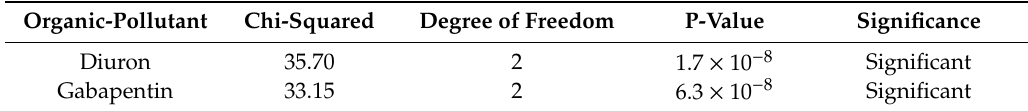
Table 5. Kruskal–Wallis rank sum test.